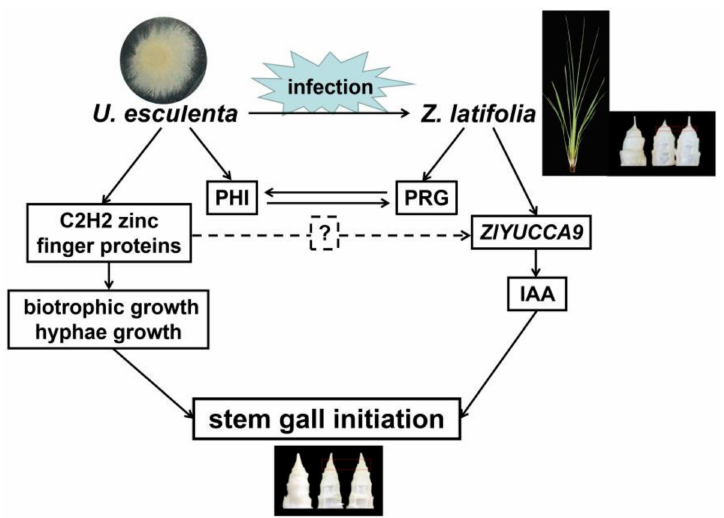
Figure 10. A proposed model of the interaction mechanism between Z. latifolia and U. esculenta for stem-gall induction deduced from mixed transcriptome analysis. At this stage, the hyphae of U. esculenta extend fast and invade into stem apex cells of the host, which may be promoted by the C2H2 zinc finger proteins. The wide distribution of hyphae into the host tissue would facilitate triggering gall enlargement after initiation stage. Fungal pathogen–host interaction genes (PHI) and plant resistant genes (PRG) are reprogrammed to maintain the unique balance between the parasite and the host. IAA stimulating Jiaobao stem-gall initiation is mainly synthesized by Z. latifolia , and ZlYUCCA9 may play a key role in this process. C2H2 zinc finger proteins of U. esculenta may also participate into the IAA synthesis of Z. latifolia